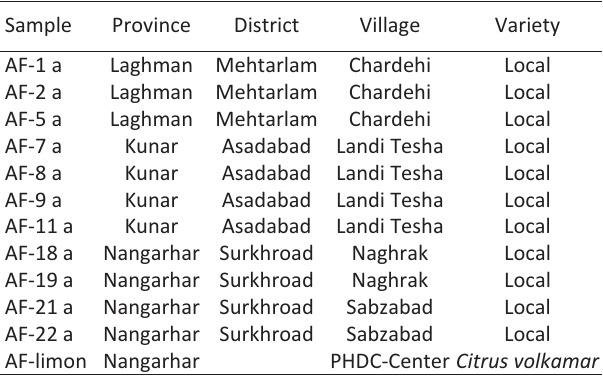
Table 1 - List of the samples coming from Afghanistan